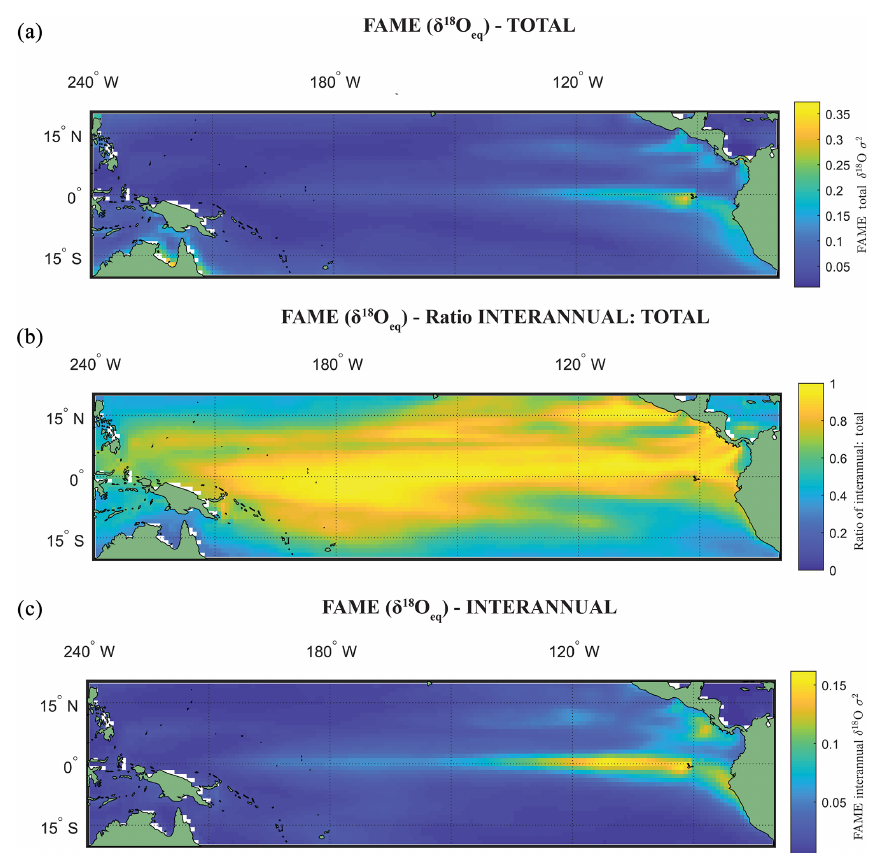
Figure 3. Total variance and interannual variance. (a) Total variance in Globigerinoides sacculifer δ 18 O c , using FAME δ 18 O eq for a cut-off value of 60m. (b) The ratio of (a) and (c) , where (c) is the interannual variance in the time series of (a)